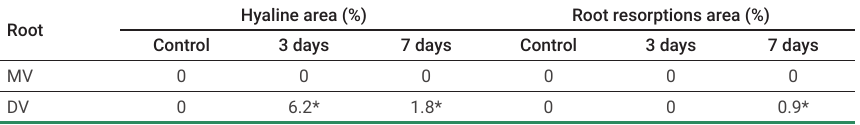
Table 1. Mean of hyaline percentage area of PDL and percentage of root resorption, found in each group, according to the OTM period and root analyzed. Hyaline area (%) Root resorptions area (%) Root Control 3 days 7 days Control 3 days 7 days MV 0 0 0 0 0 0 DV 0 6.2* 1.8* 0 0 0.9* * Statistically significant compared to the Control Group on each root analyzed (p≤0.05). MV - mesiovestibular root.